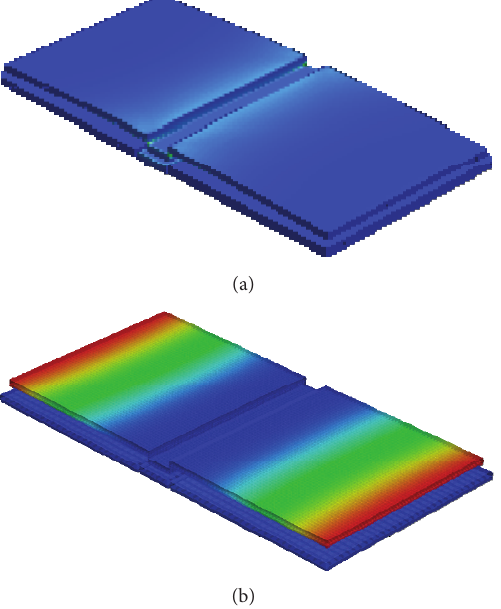
F 7: (a) Anchor stress simulations and (b) MEMS capacitor stress simulations along the 𝑦𝑦